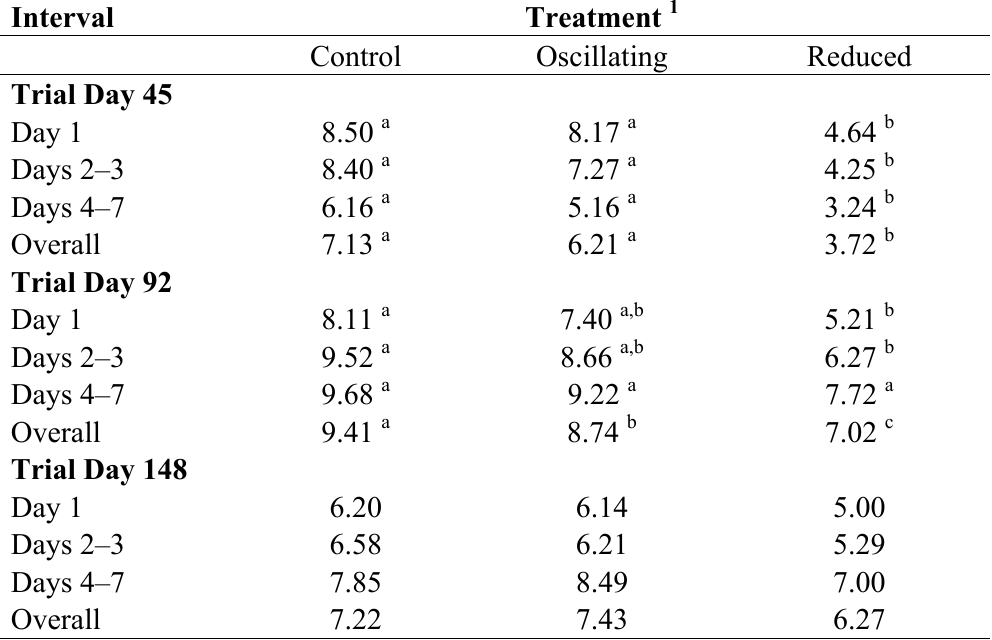
Table 2. Effect of dietary crude protein treatment on ammonia emissions (g m − 2 ·day − 1 ) by chamber day